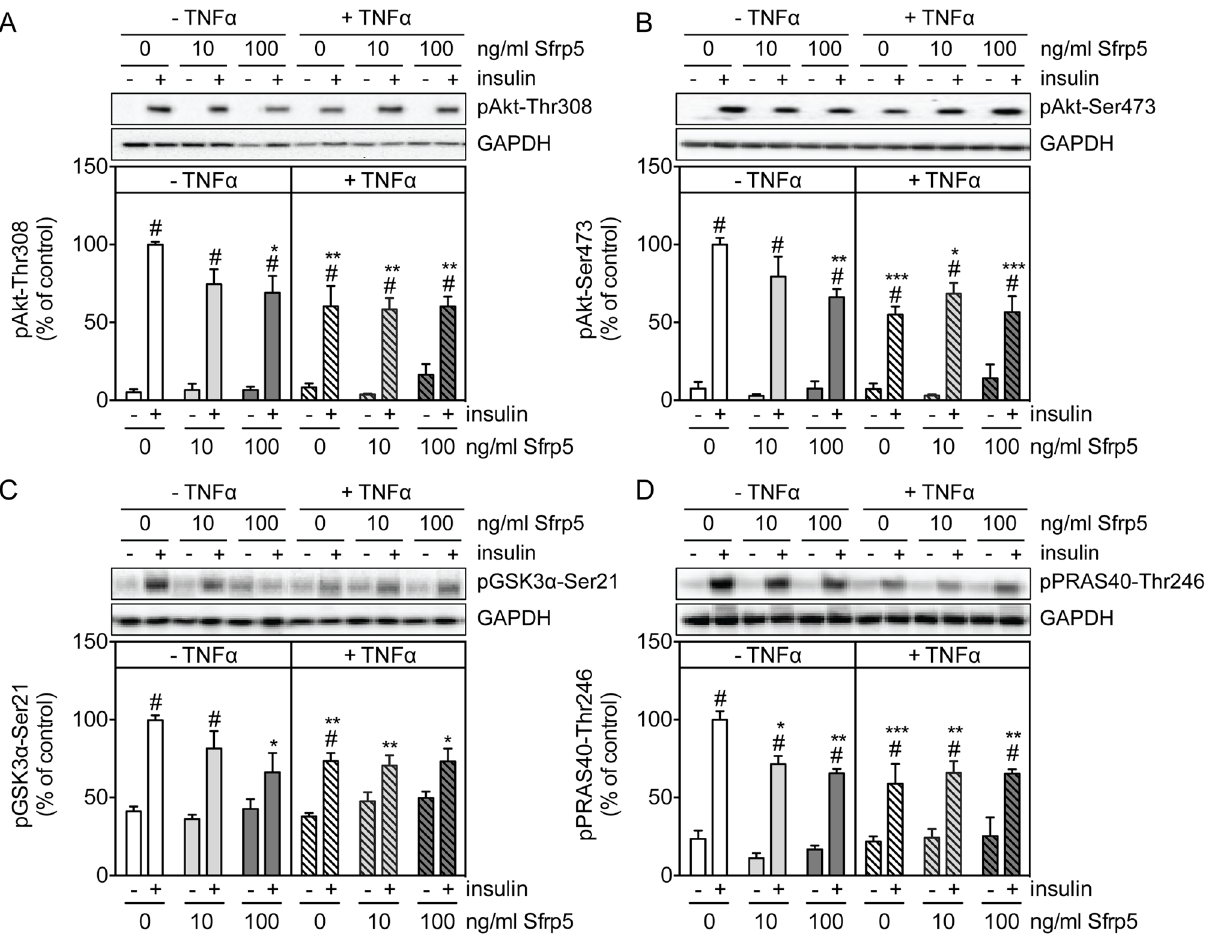
Figure 3. Effect of Sfrp5 on insulin signaling in primary human adipocytes. Primary human adipocytes were kept untreated, exposed to Sfrp5 for 24 h, or to 5 ng/ml TNF a for 24 h with or without a 4 h preincubation with Sfrp5. Then, when indicated ( + ) cells were stimulated with insulin (10 min; 100 nM). Cell lysates were analyzed for phosphorylation of Akt-Thr308 (A), Akt-Ser473 (B), GSK3 a -Ser21 (C) and PRAS40-Thr246 (D) by Western blotting. Phosphorylation signals were normalized for GAPDH protein abundance and expressed as mean 6 standard error of the mean of five independent experiments using cells from different donors. The values obtained for Sfrp5-untreated, insulin-treated cells were considered as control and set at 100%. Differences among groups were calculated by two-way ANOVA followed by Bonferroni multiple comparison analysis. # , indicates p , 0.05 for the effect of insulin stimulation; ***, p , 0.001; **, p , 0.01; *, p , 0.05 versus untreated cells.